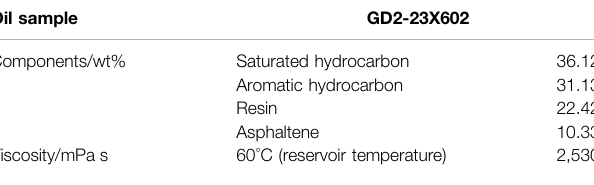
TABLE 1 | Components and physical properties of crude oil.